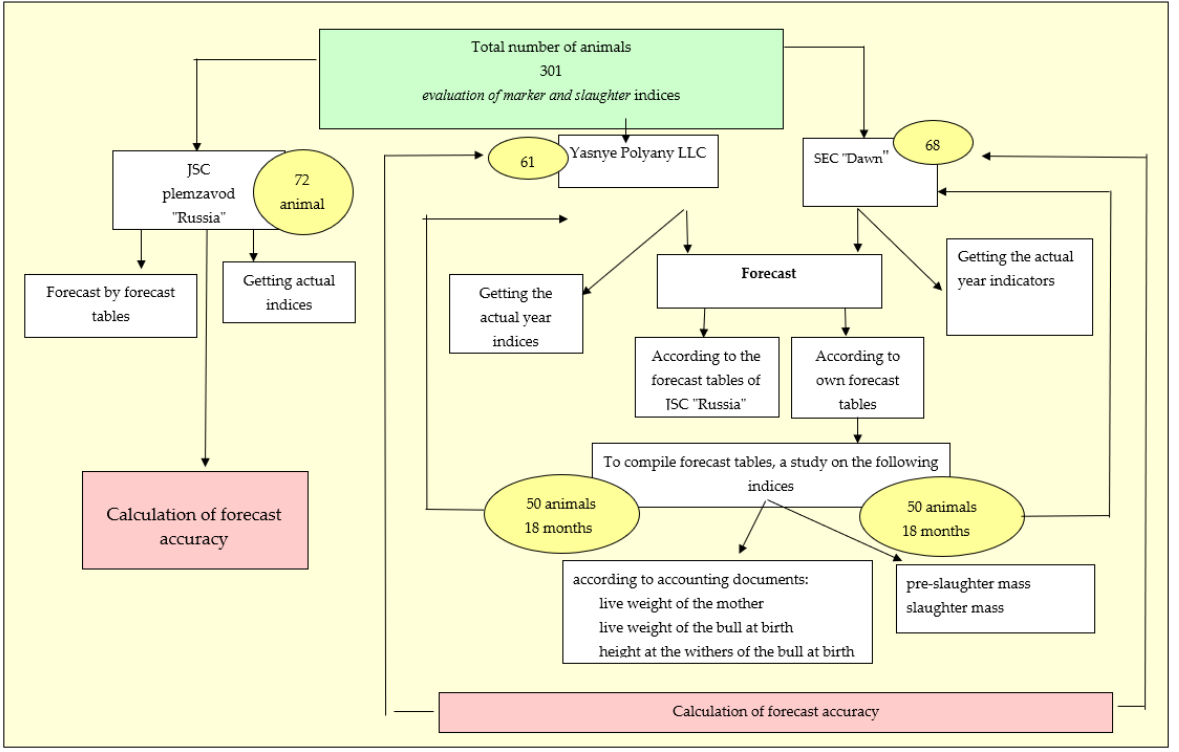
Figure 5. Scheme of approbation method of predicting meat productivity.